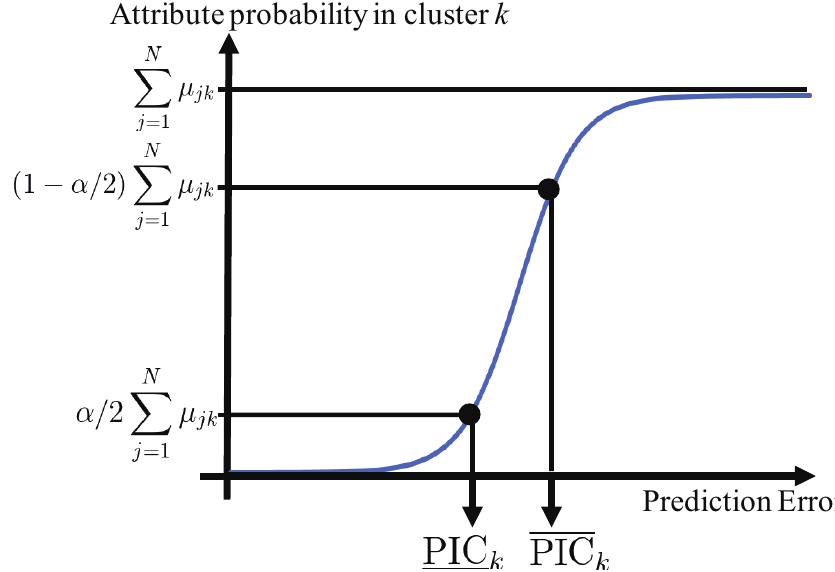
Figure 3. Overview of the empirical distribution function for calculating lower and upper values of the prediction interval in cluster k